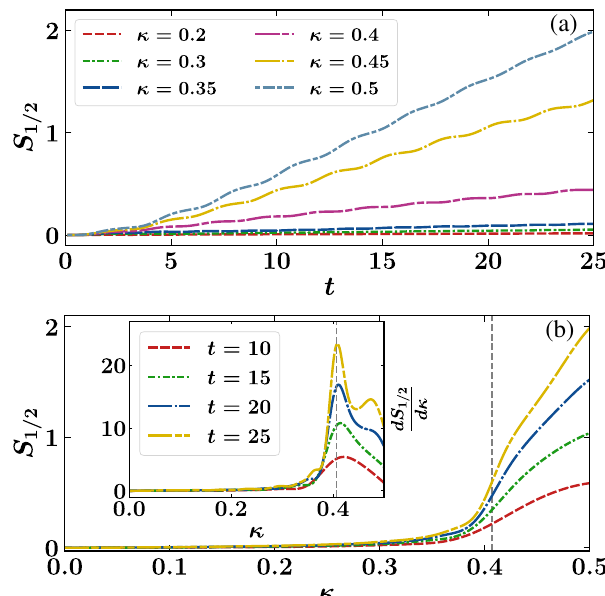
FIG. 4. Ferromagnetic to paramagnetic quantum phase tran- sition in the ANNNI chain as revealed via real-time dynamics of the half-chain entanglement entropy S 1 = 2 . (a) Time evolution of S κ . (b) S 1 = 2 for six values of 1 = 2 at different times plotted as a function of κ . Inset: derivative with respect to κ of the results shown in the main figure. The initial state for the dynamics is the ground state of the ANNNI Hamiltonian with Γ ¼ 0 . 2 and κ ¼ 0 . The vertical dashed lines mark the critical κ ≈ 0 . 41 . I c